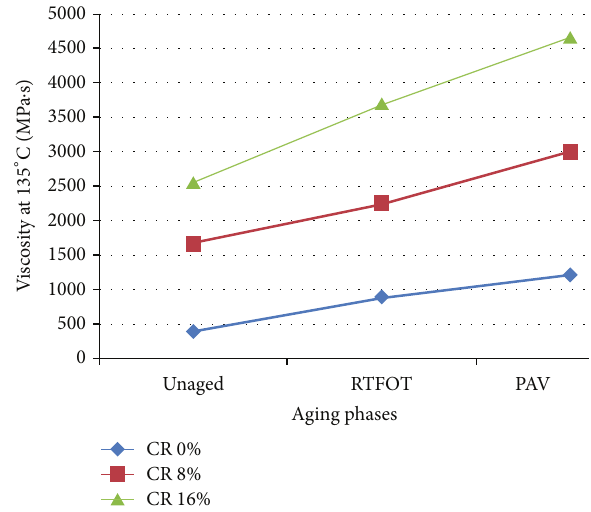
Figure 2: Brookfield viscosity results of CRM binders versus aging conditions.